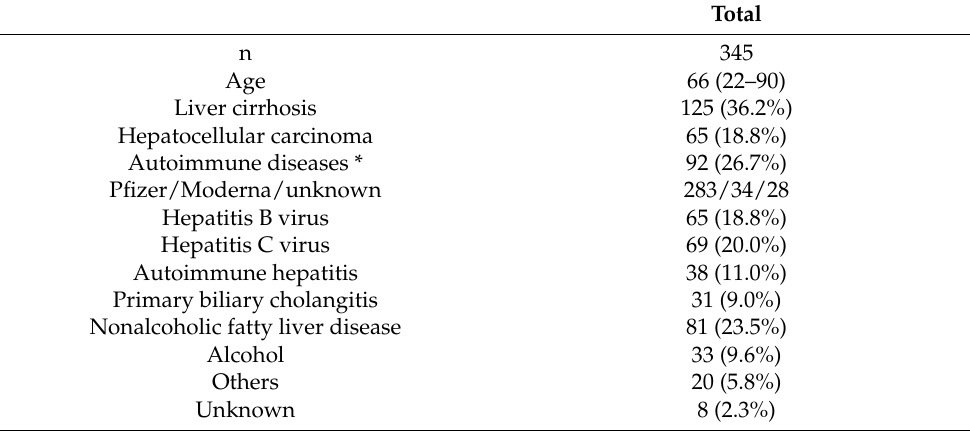
Table 2. Background of patients.